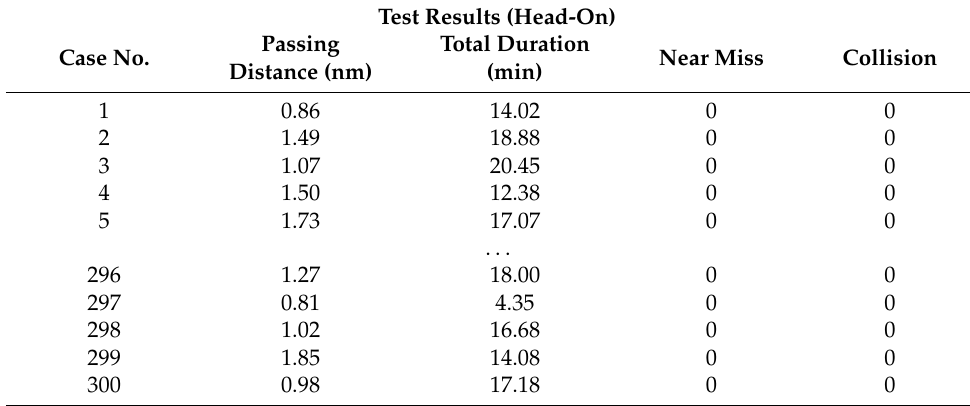
Table 7. Test results in head-on scenarios.